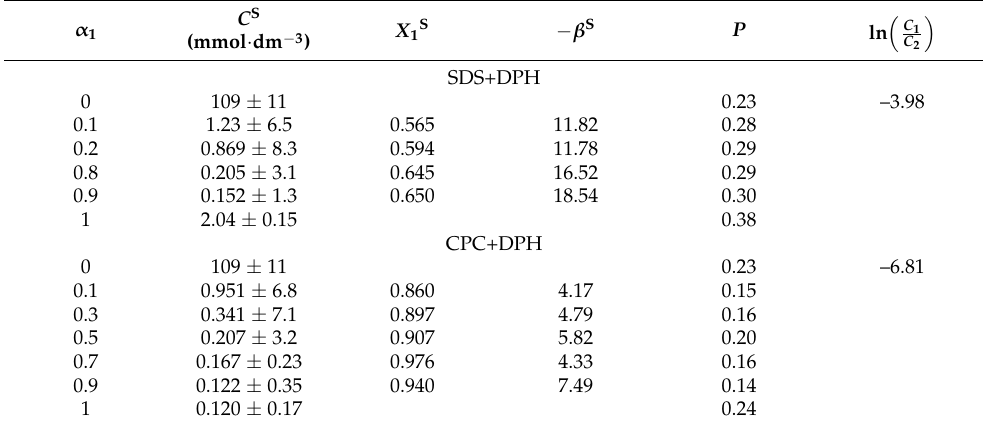
Table 3. Molar concentrations ( C S ), micellar mole fraction at surface ( X 1S ), interaction parameter at surface ( β S ), packing parameter ( p ) and CMC/ C 20 of DPH and SDS/CPC mixed systems at temperature T = 298.15 K. Values are the mean ± SD ( n =